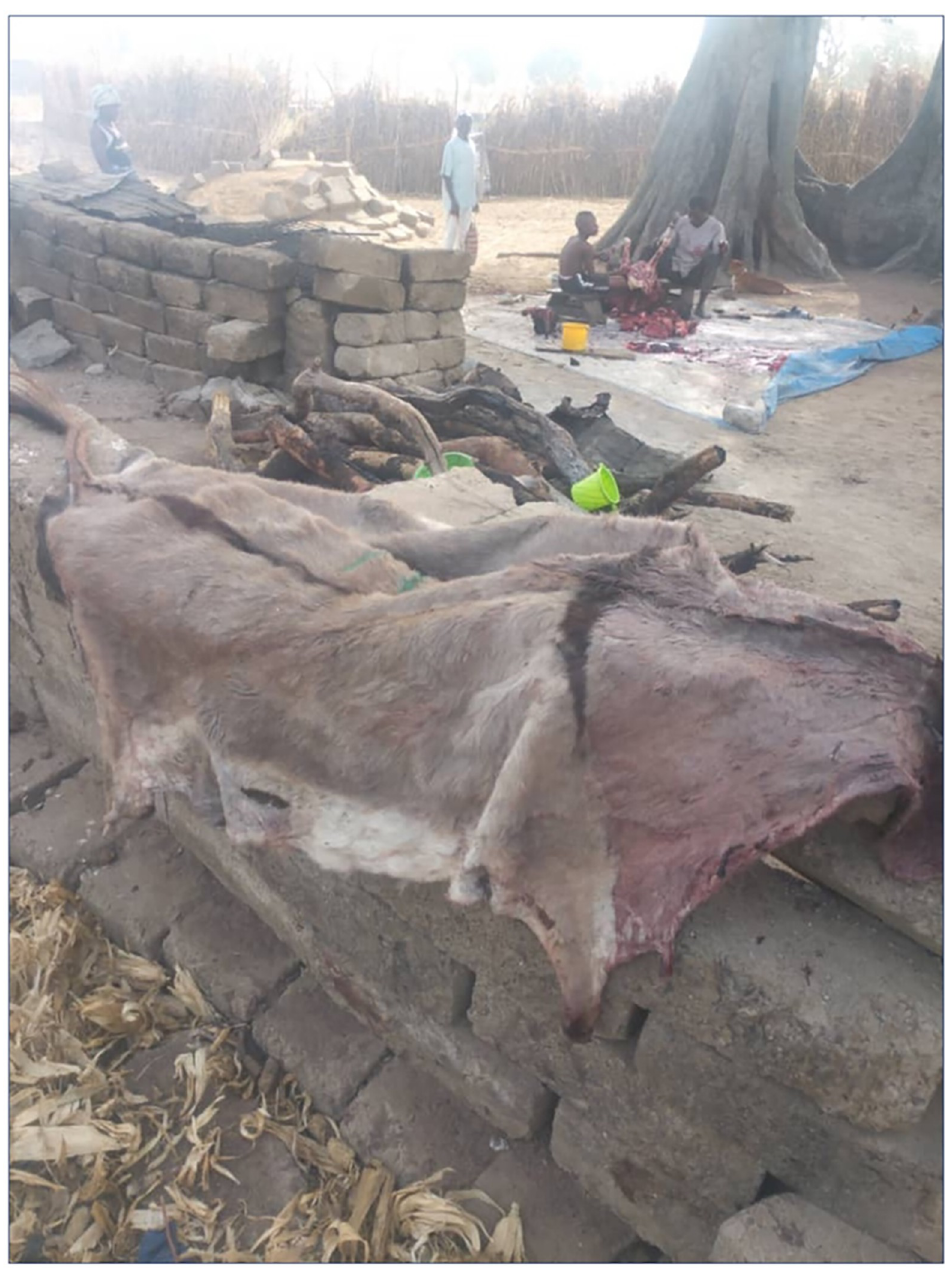
Fig 7. The hide of a recently killed donkey in Gia (UER), to be sold to Chinese buyers, December 2018. Source: © Wepiah, 2019, cc BY